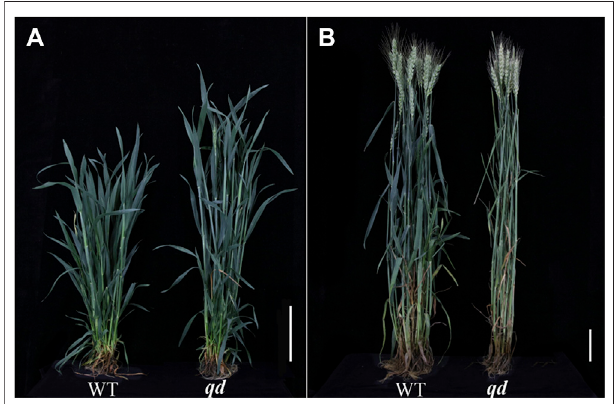
FIGURE 1 | Heights of WT and qd plants at various stages. Bar (cid:1) 8 cm. (A) Typical plants at the booting stage; (B) Typical plants at the mature